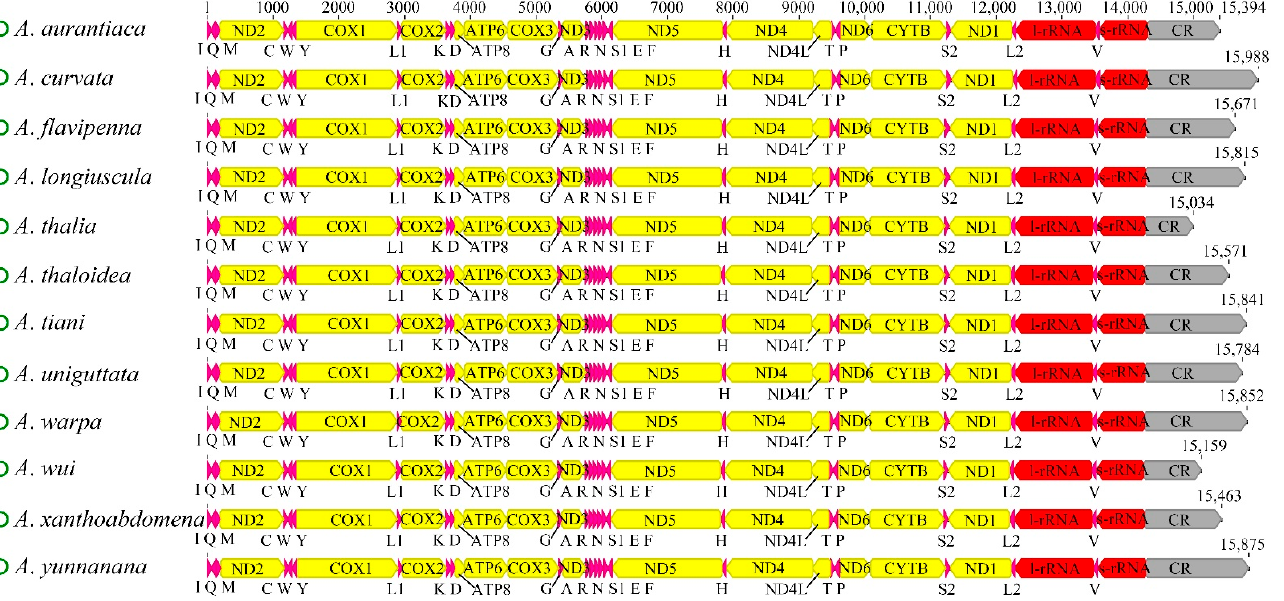
Figure 1. Characteristics of 12 newly sequenced mitochondrial genomes of Atkinsoniella species. Protein coding and ribosomal genes are shown with standard abbreviations. Transfer RNA (tRNA) genes are indicated using the IUPAC-IUB single letter amino acid codes (L1, CUN; L2, UUR; S2). The green circles in front of the species names represent circular mitochondrial genomes. The sharp angle of color blocks on the right and left indicates that the genes were on the J-strand and N-strand, respectively.